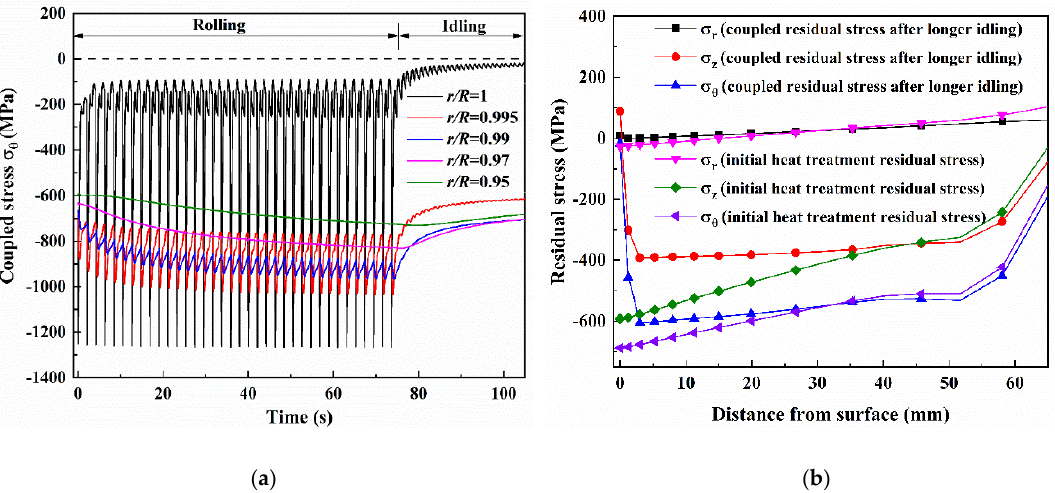
Figure 11. ( a ) Histories of the coupled stress σ θ of thermal stress and heat treatment residual stress with the different depths during the whole hot rolling of one strip and the subsequent idling, ( b ) comparison of initial heat treatment residual stress and coupled residual stress after longer idling.